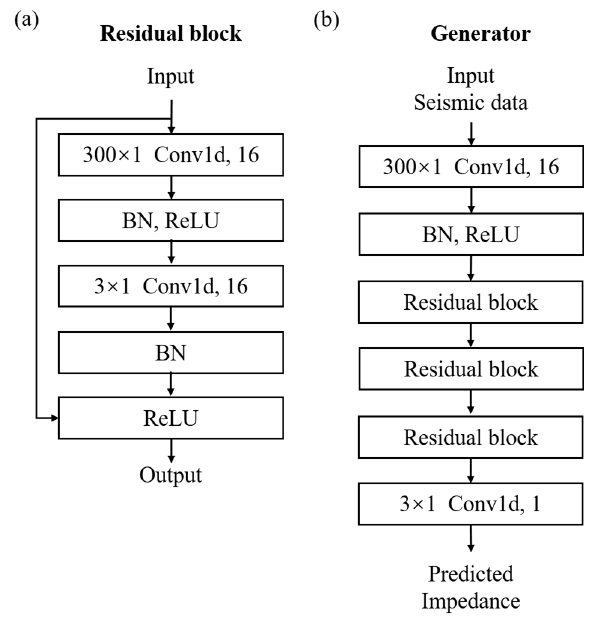
Figure 1. The architecture of the ( a ) residual block and ( b ) generator.